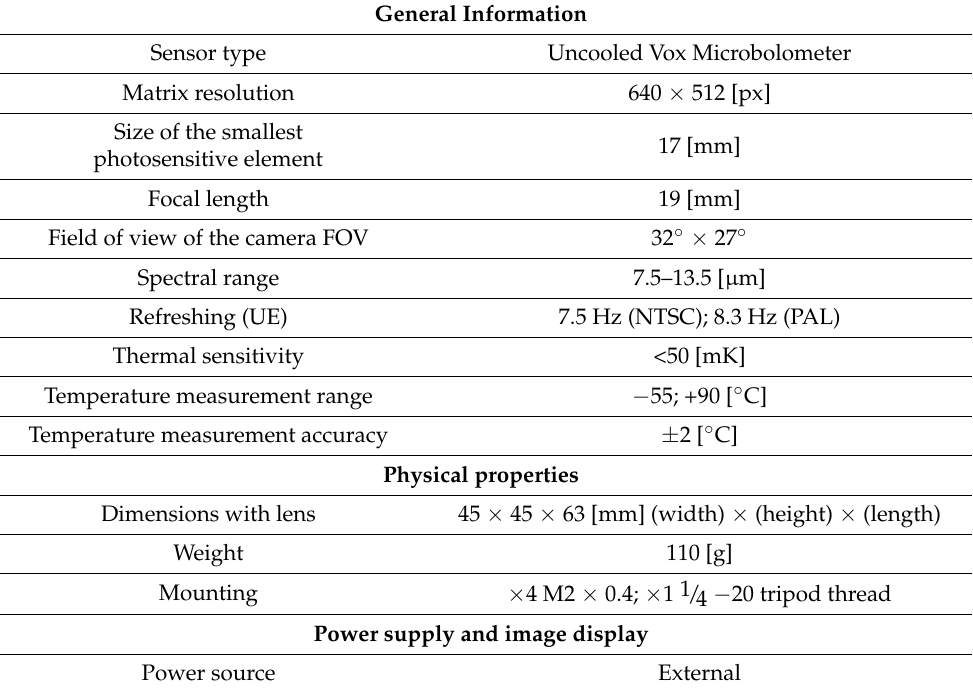
Table 1. Technical specifications of the FLIR VUE PRO R 640 thermal camera [60] .